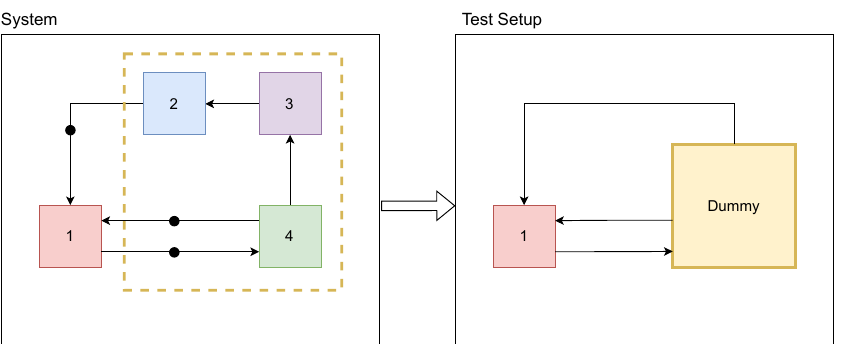
Figure 9. Test generation procedure: From the collected data (black dots) of participants 2, 3, and 4, a test dummy is automatically created to simulate the system and test participant 1 without running the other participants